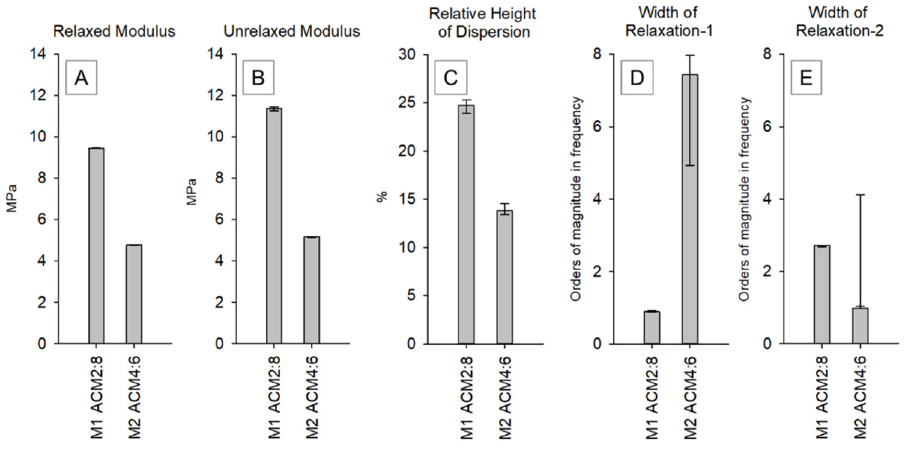
Figure 7. Characteristic values for both copolymers; ( A ) relaxed modulus at f = 0; ( B ) unrelaxed modulus at f = ∞ ; ( C ) height of global dispersion relative to unrelaxed modulus; ( D ) width of relaxation region-1; ( E ) width of relaxation region-2.